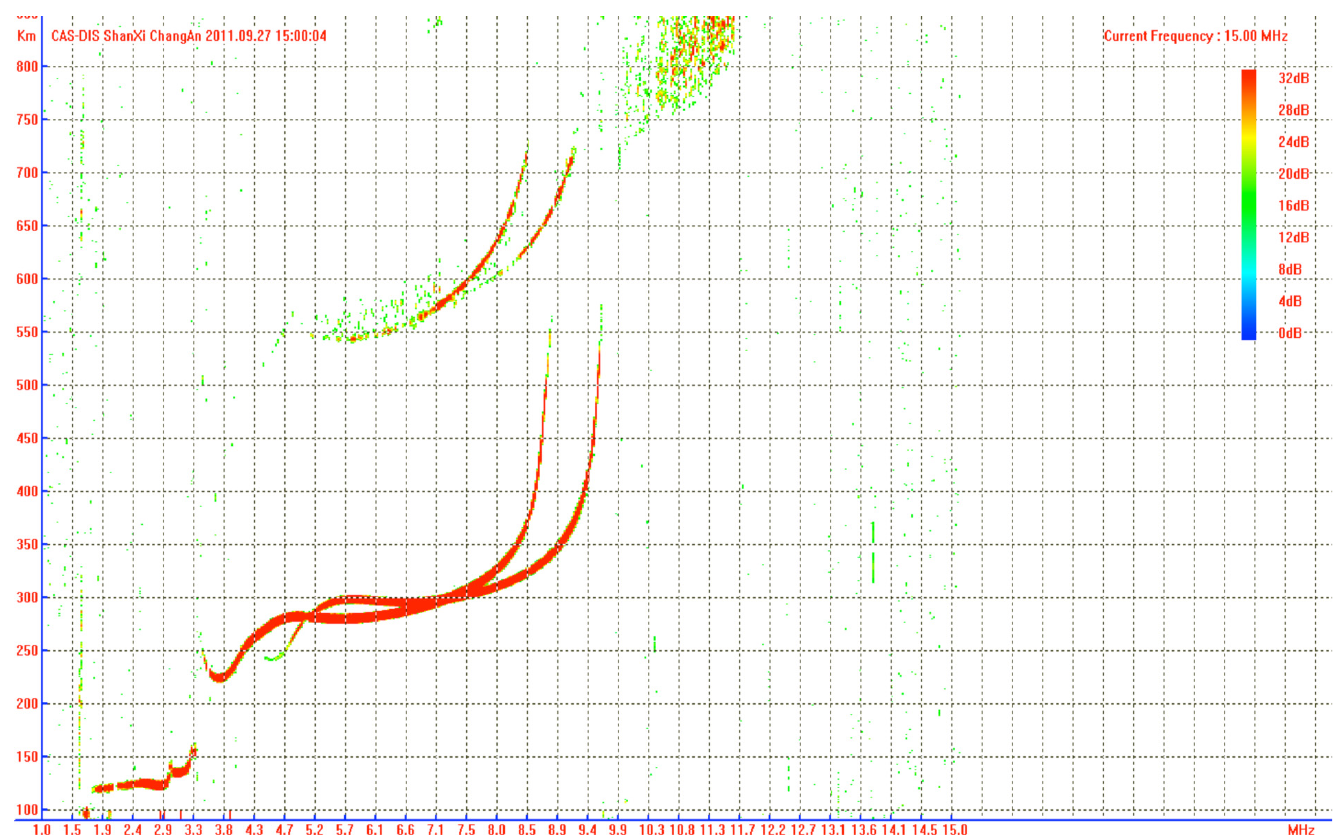
Figure 11. Test result of the CAS-DIS on Septemper 27, 2011, for the Shanxi Chang'an station (16-bit complementary